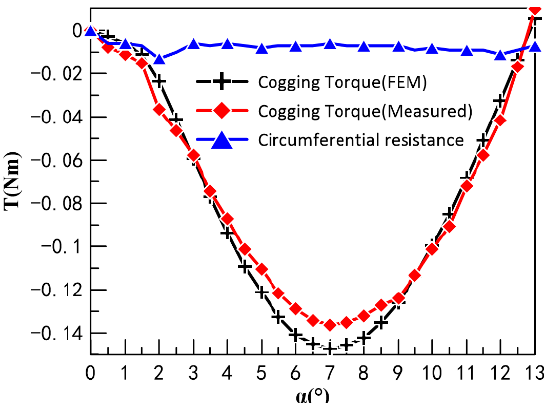
Figure 21. The cogging torque angle characteristics of CPMLTM, Circumferential angular displace- ment_Circumferential resistances.